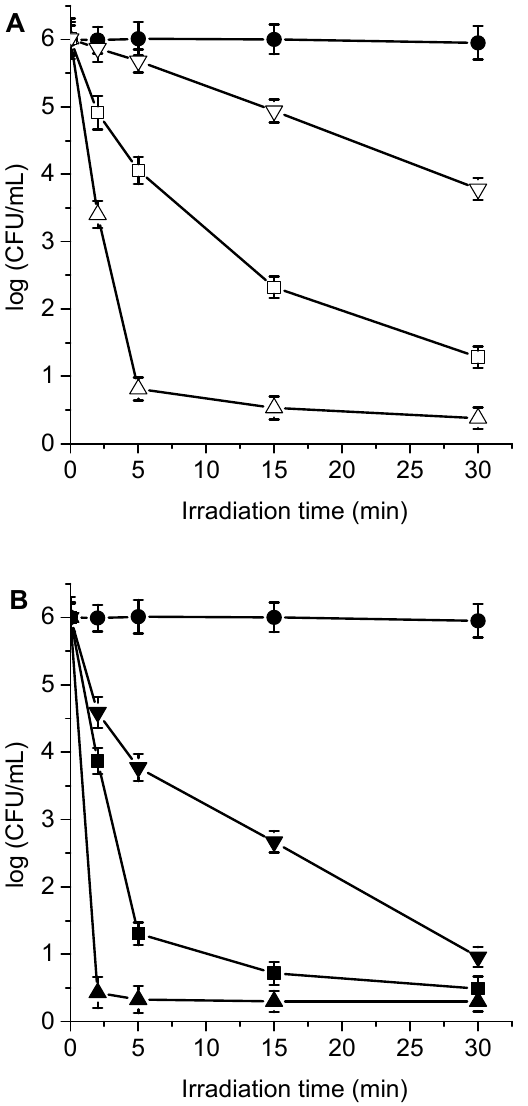
Figure 10. Survival of C. albicans pseudohyphae (~10 6 UFC/mL) treated with ( A ) 1 µ M TPCF 16 ( △ ), 1 µ M ZnTPCF 16 ( ~ ), 1 µ M PdTPCF 16 ( ▽ ), ( B ) 5 µ M TPCF 16 ( ▲ ), 5 µ M ZnTPCF 16 ( ■ ), and 5 µ M PdTPCF 16 ( ▼ ) for 30 min at 37 °C in the dark and irradiated with white light for different irradiation times. Control of C. albicans pseudohyphae untreated with PS and irradiated ( • ).